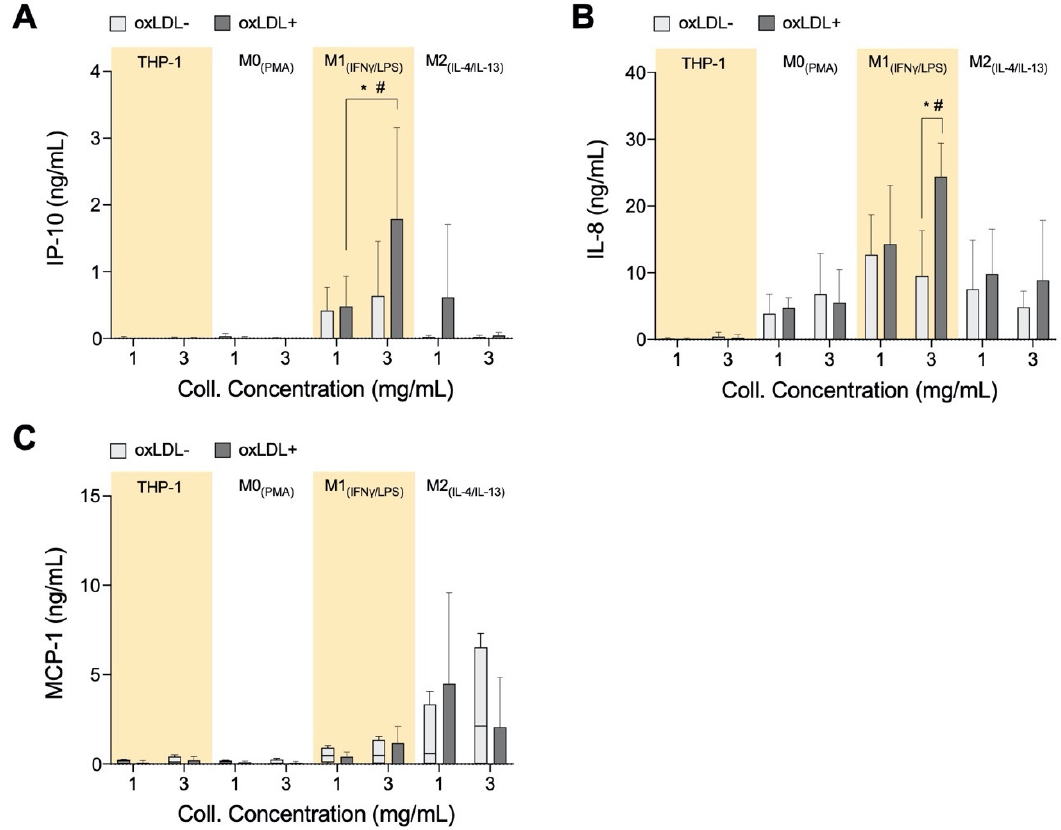
Figure 4. Chemokine secretome from monocytes and macrophages cultured in 3D collagen hydrogels. Box plots of absolute secretion levels of ( A ) IP-10, ( B ) IL-8, and ( C ) MCP-1 to observe trends and indicate comparisons that are statistically significant. The dotted line in box plots marks the lowest detectable concentration of assay. Statistical significance has been determined by two-way ANOVA followed by Tukey’s test, and the level of significance is represented as * p < 0.05 and # p < 0.05 in 3 mg / mL between THP-1 + LDL , M0 + LDL, and M2 + LDL vs. M1 + LDL . The dotted horizontal line indicates the lowest detectable limits of the assay.